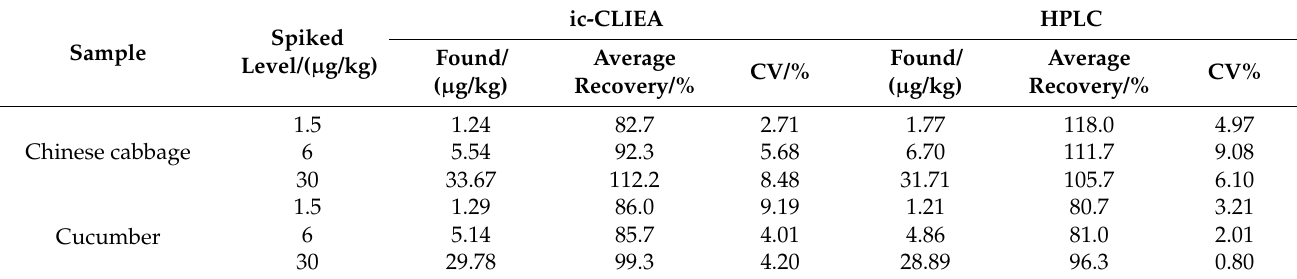
Table 2. Recoveries of acetamiprid in Chinese cabbage and cucumber ( n = 3).